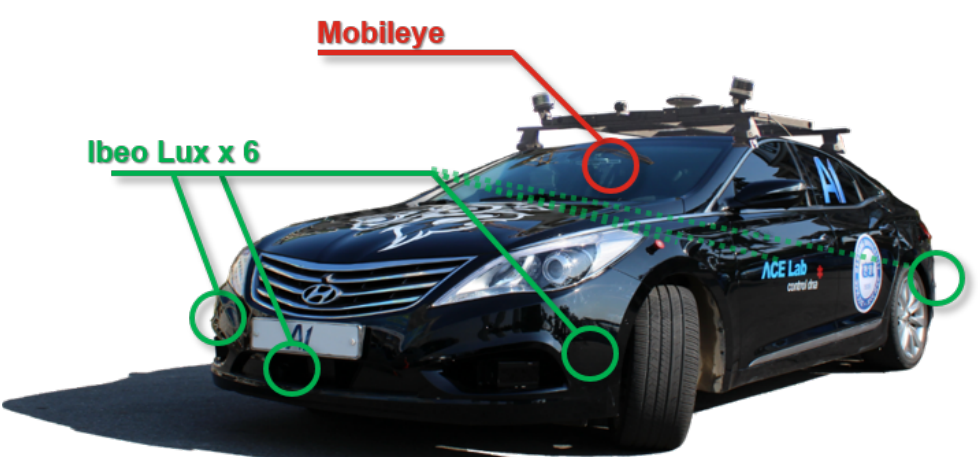
Figure 5. Sensor configuration of the test vehicle A1.